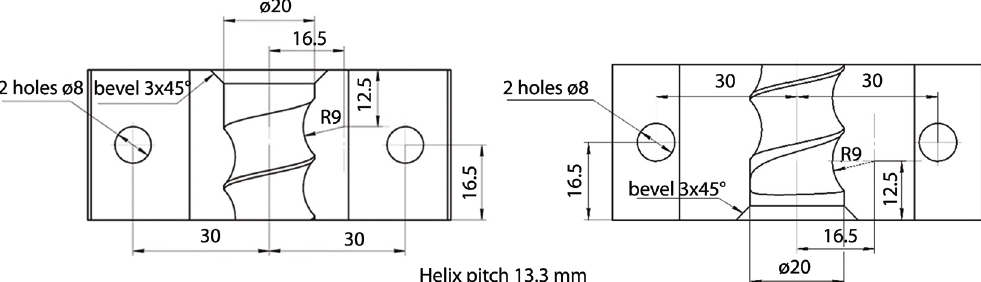
Figure 2: Die channel scheme.